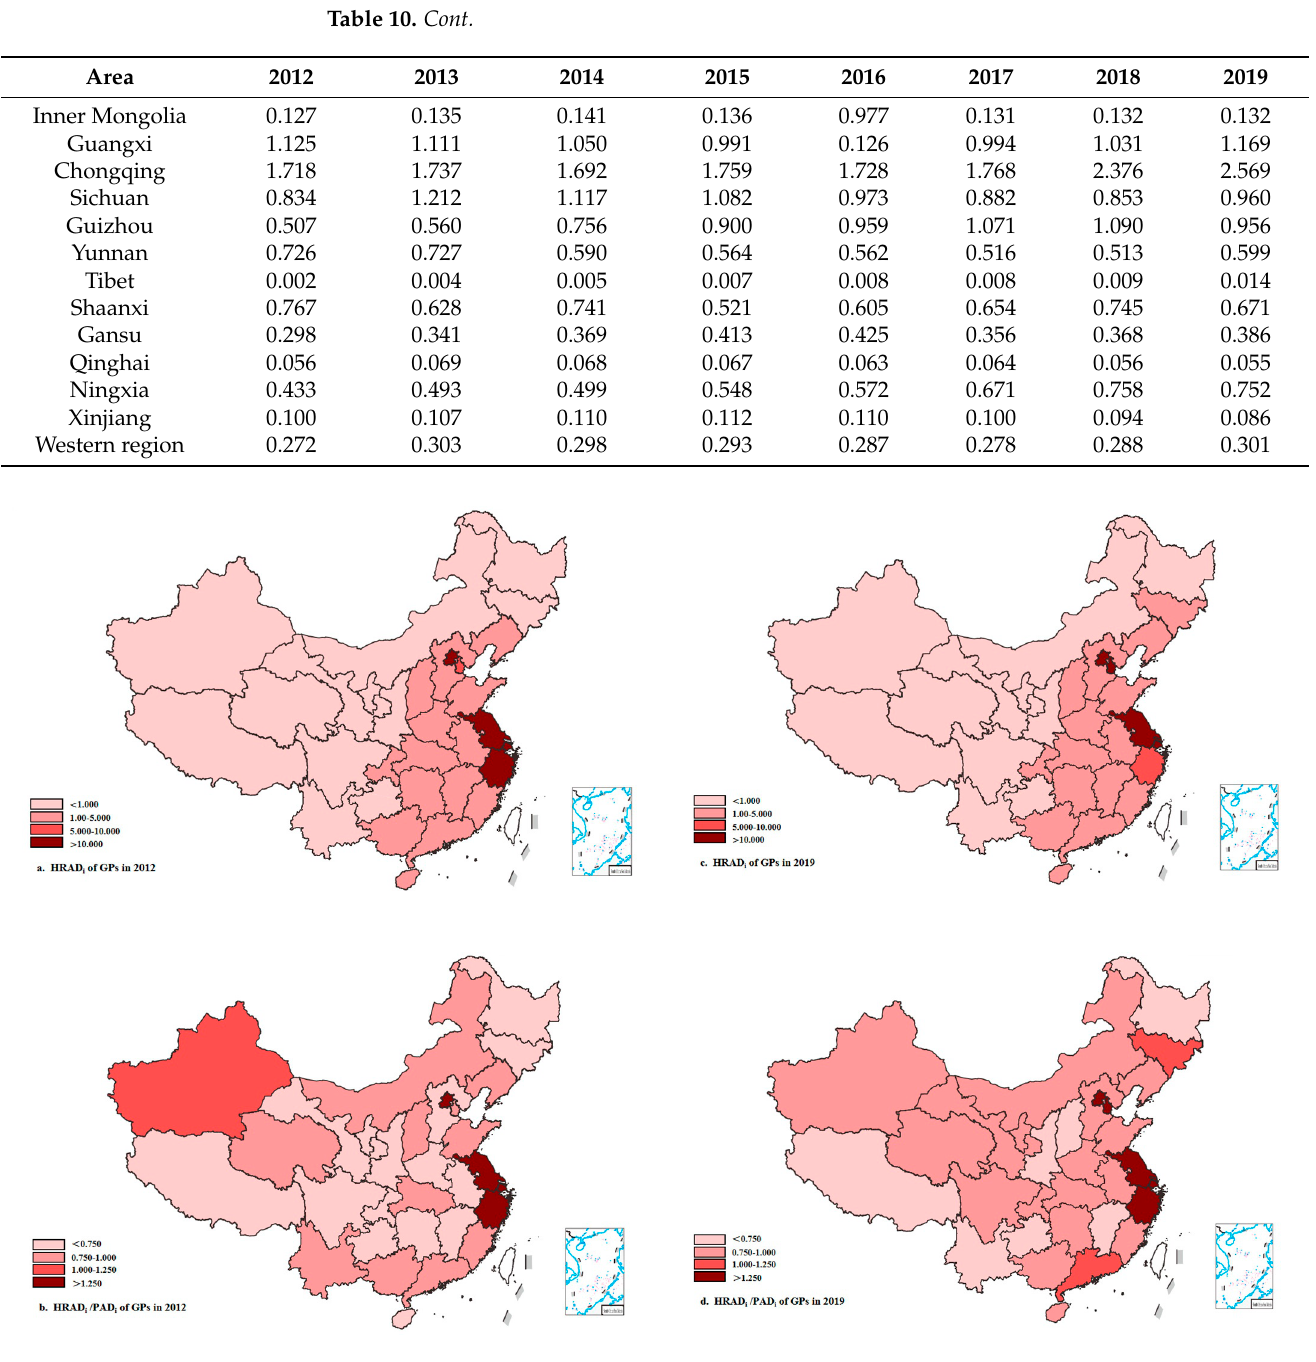
Figure 2. The HRAD i and HRAD i /PAD i of GPs in 2012 and 2019. The agglomeration degrees based on population allocation are shown in Table 11. In 2019, the agglomeration degrees in the eastern, central, and western regions were 1.262, Table 10. The HRAD i of GP allocation in 2012–2019 in China. 0.835, and 0.787, respectively. The agglomeration degrees in the central and western regions increased from 2012 to 2019. This finding shows that GP resource allocation based on population was insufficient in the central and western regions. Although the agglomeration degree in the eastern region decreased from 2012 (1.460) to 2019 (1.262), the values were greater than 1, which indicated that GPs were too concentrated based on the population. From the analysis of different provinces, autonomous regions, and municipalities, the resource allocation of GPs in Chongqing (0.999) had absolute equity. The agglomeration degrees in Tianjin (1.125), Jilin (1.077), Guangdong (1.066), and Qinghai (0.958)